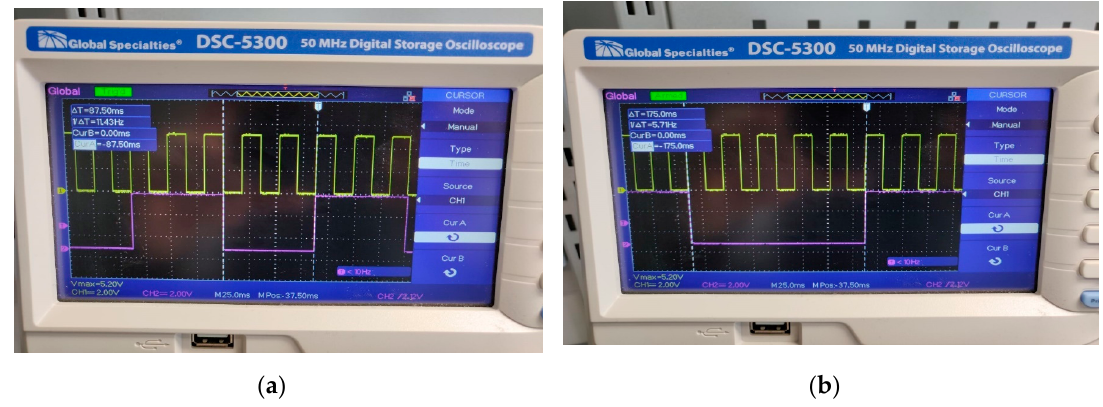
Figure 9. ( a ) Medium (purple) and short task (yellow); ( b ) Long (purple) and short task (yellow).